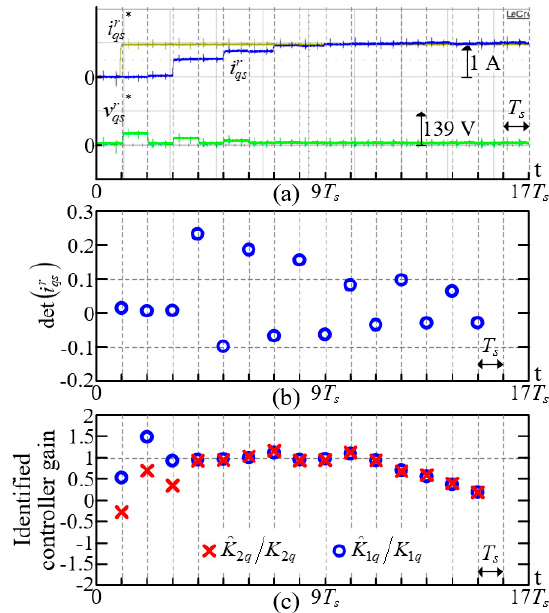
Figure 20. Current command steps from 0 A to 1 A when the motor is at standstill and ˆ L qs = 0.5 L qs , ( a ) q -axis current and voltage command, ( b ) det